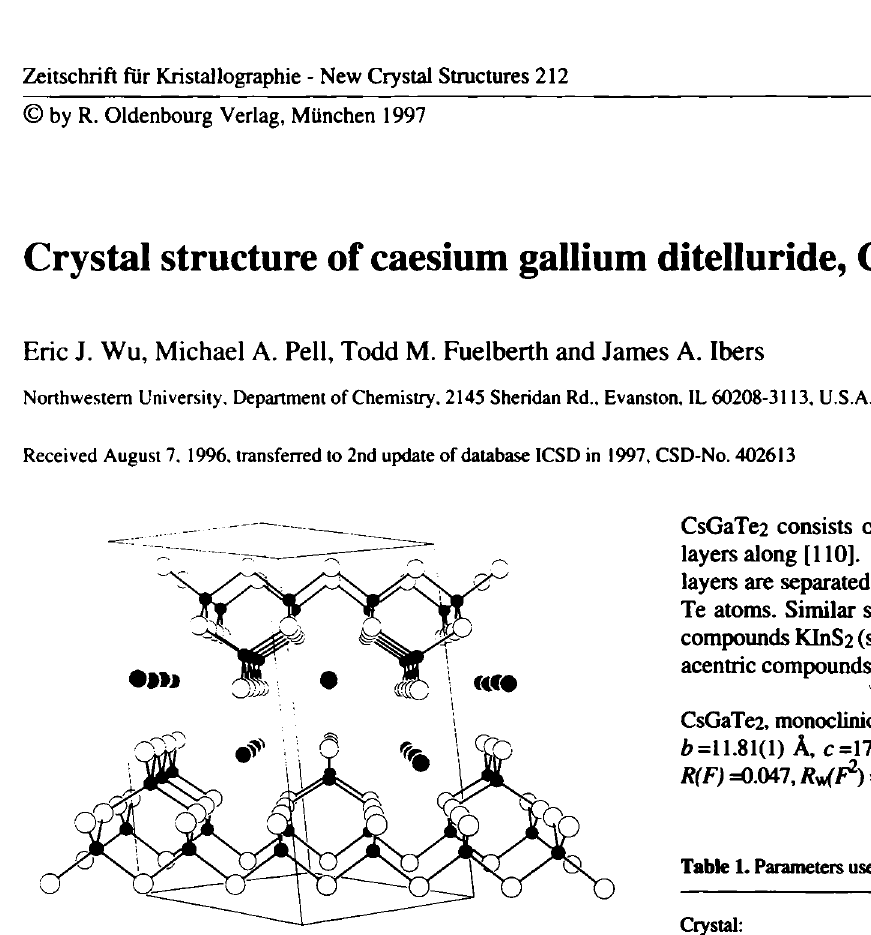
Fig. 1. View along the [110] direction.